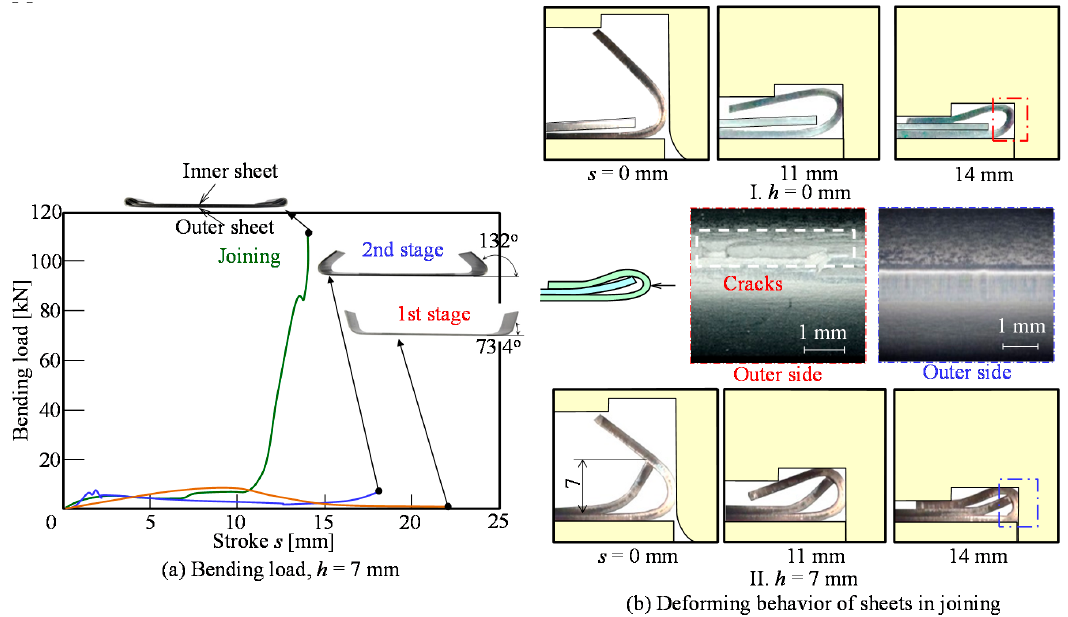
Figure 8. Load–stroke curves in hemming process and deforming behavior of sheets in third stage for 1180 MPa steel sheets and inner burr.